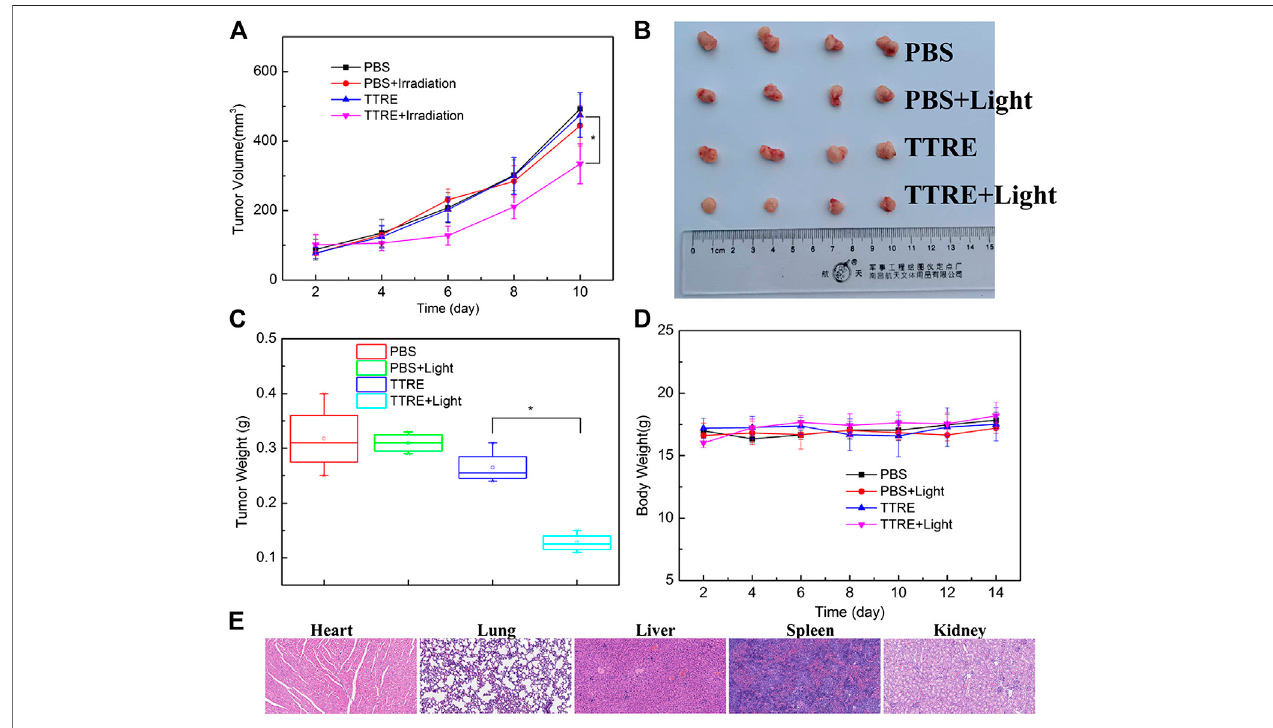
FIGURE 5 | (A) Tumor volumes under different treatments; (B) Photos of typical tumor after different treatments; (C) Tumor weight under different treatments; (D) Body weights of the mice under different treatments; (E) H&E stained sections of heart, lung, liver, Spleen and